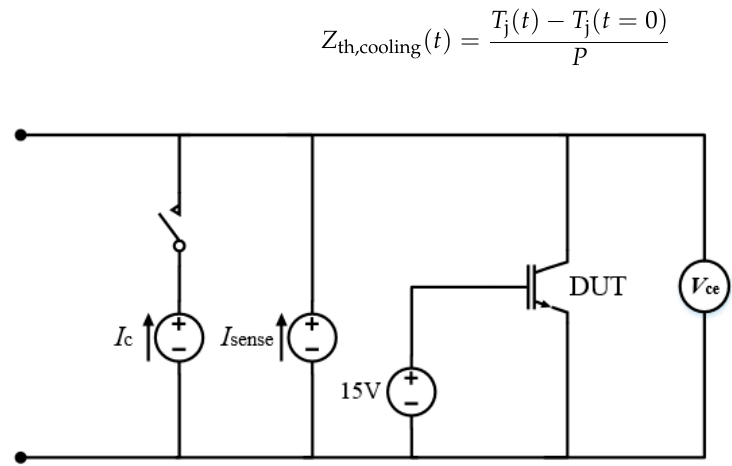
the cooling process is calculated using the K curve. Then, from the T j ( t ) and the heating power P , the transient thermal impedance curve Z th, cooling ( t ) during the cooling process can be obtained, as shown in Figure 6.